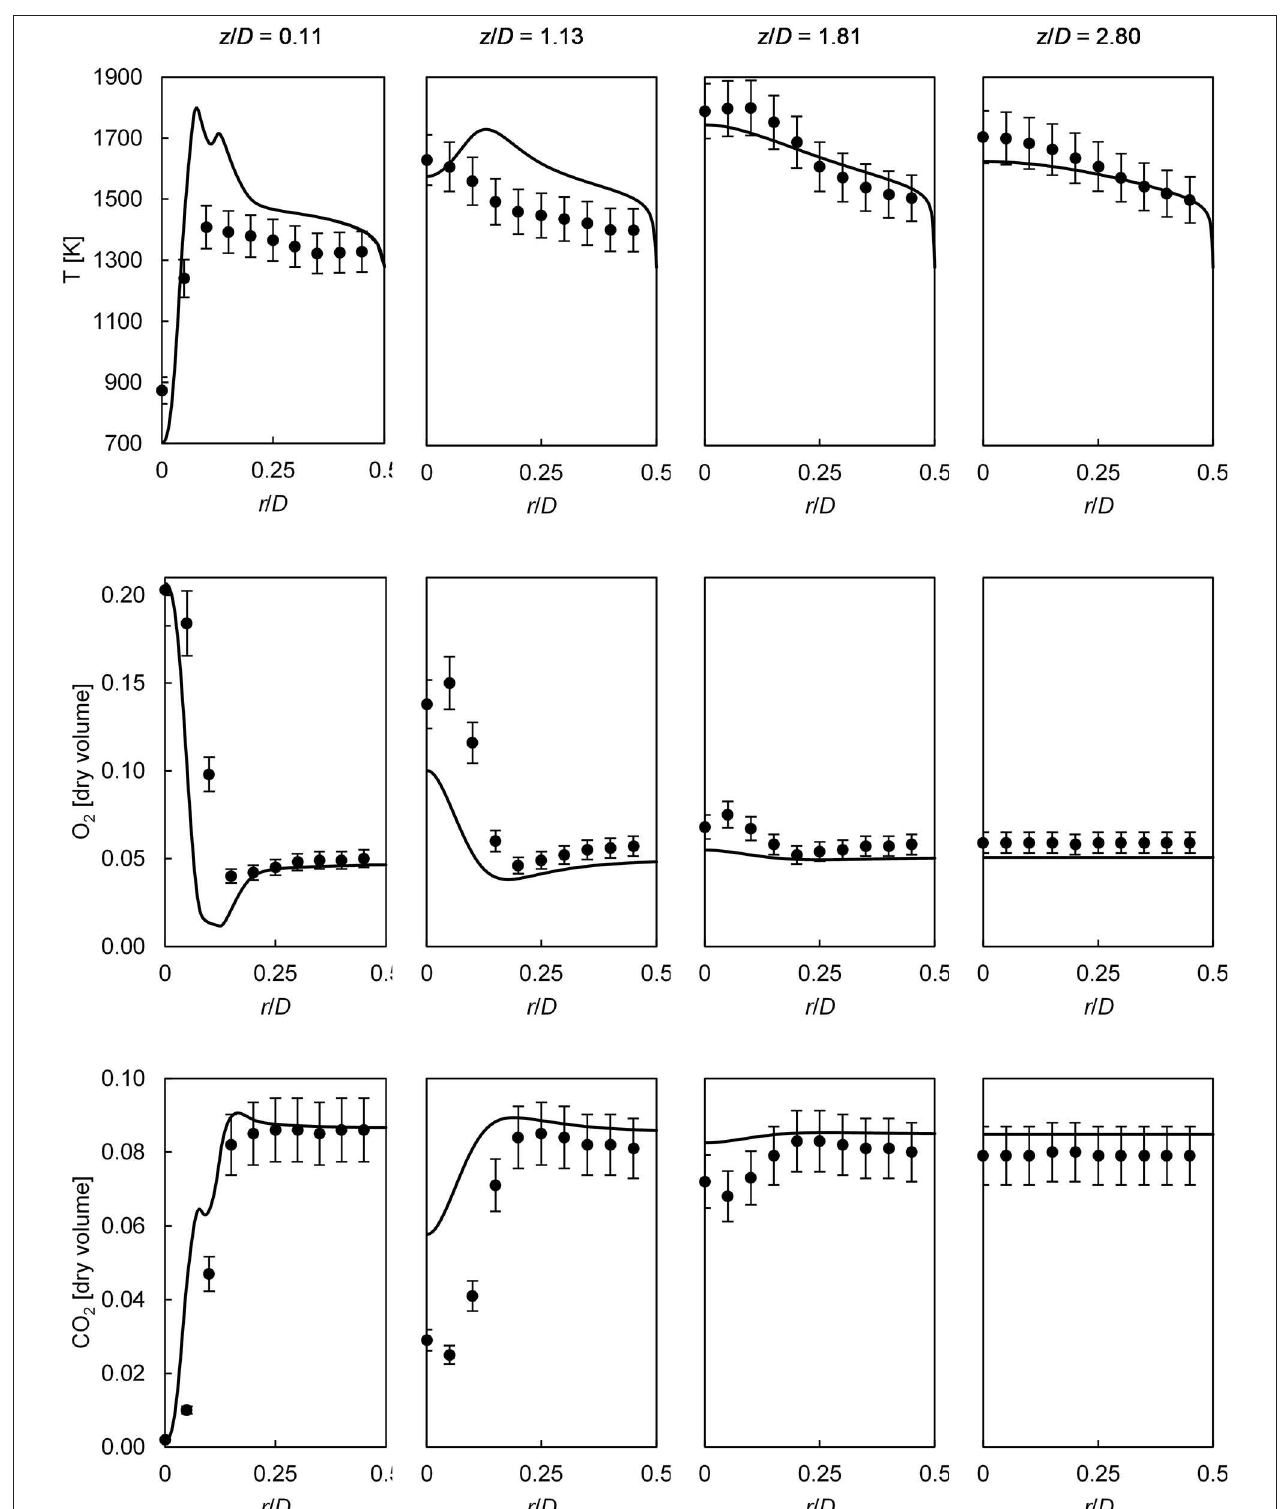
FIGURE 7 | Comparisons of experimental and CFD (FGM) parameters: temperature, O 2 concentration, and CO 2 concentration results along radial lines for condition b ( φ ∼= 0.77).